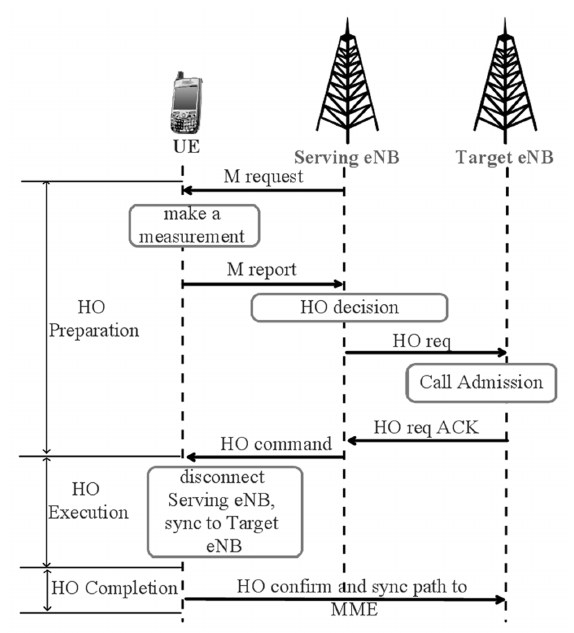
Figure 6. Existing hard HO procedure for user equipment (UE) in